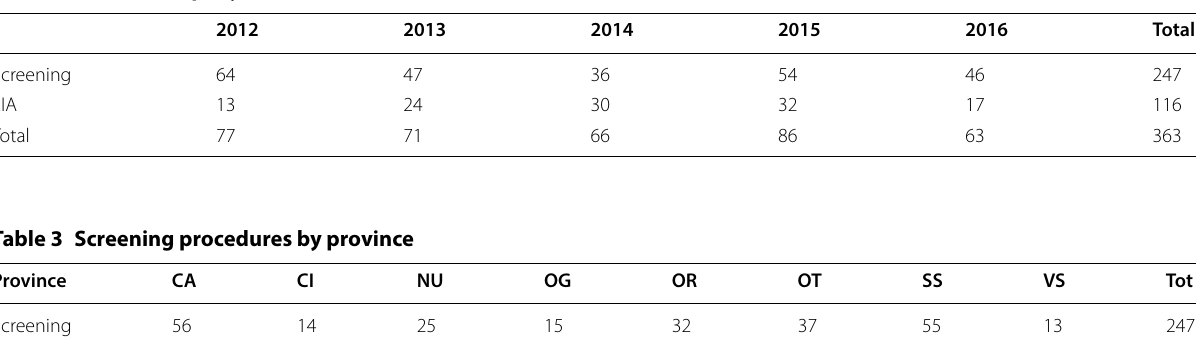
Table 2 Procedures per year